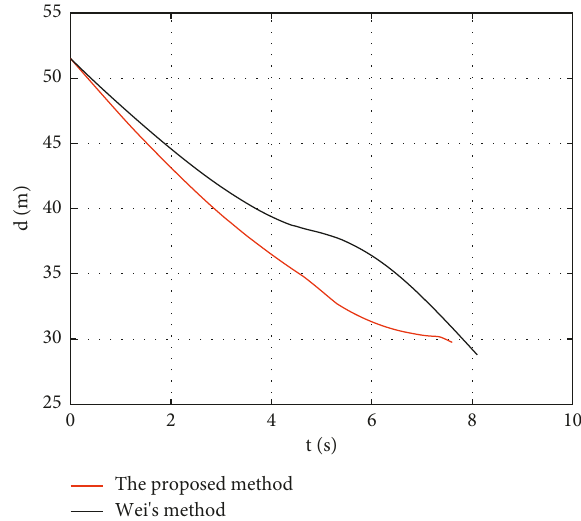
Figure 11: The comparison of cost function ( N � 9, λ � 0 . 75).